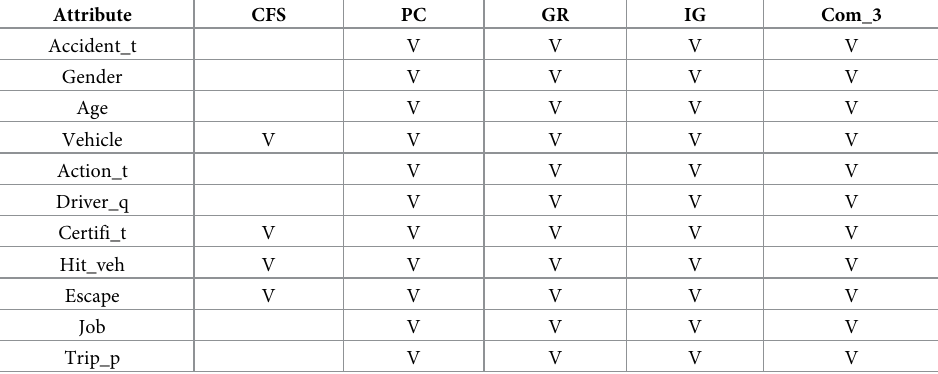
Table 7. Results of the four attribute selection methods and COM_3 in the CF � 10